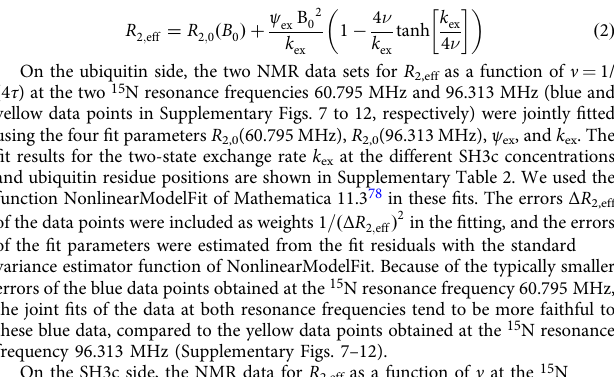
On the ubiquitin side, the two NMR data sets for R 2,eff as a function of ν = 1/ (4 τ ) at the two 15 N resonance frequencies 60.795 MHz and 96.313 MHz (blue and yellow data points in Supplementary Figs. 7 to 12, respectively) were jointly fi tted using the four fi t parameters R 2,0 (60.795 MHz), R 2,0 (96.313 MHz), ψ ex , and k ex . The fi t results for the two-state exchange rate k ex at the different SH3c concentrations and ubiquitin residue positions are shown in Supplementary Table 2. We used the function NonlinearModelFit of Mathematica 11.3 78 in these fi ts. The errors Δ R 2,eff of the data points were included as weights 1 = ð Δ R 2 ; eff Þ 2 in the fi tting, and the errors of the fi t parameters were estimated from the fi t residuals with the standard variance estimator function of NonlinearModelFit. Because of the typically smaller errors of the blue data points obtained at the 15 N resonance frequency 60.795 MHz, the joint fi ts of the data at both resonance frequencies tend to be more faithful to these blue data, compared to the yellow data points obtained at the 15 N resonance frequency 96.313 MHz (Supplementary Figs. 7 – 12). On the SH3c side, the NMR data for R 2,eff as a function of ν at the 15 N resonance frequency of 81.1 MHz were fi tted with the three fi t parameters R 2,0 (81.1 MHz), ψ ex , and k ex . The fi t results for k ex at the different ubiquitin